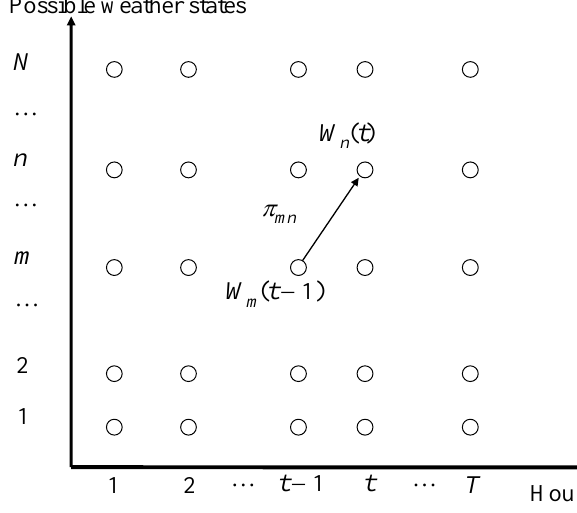
Figure 1. A Markovian